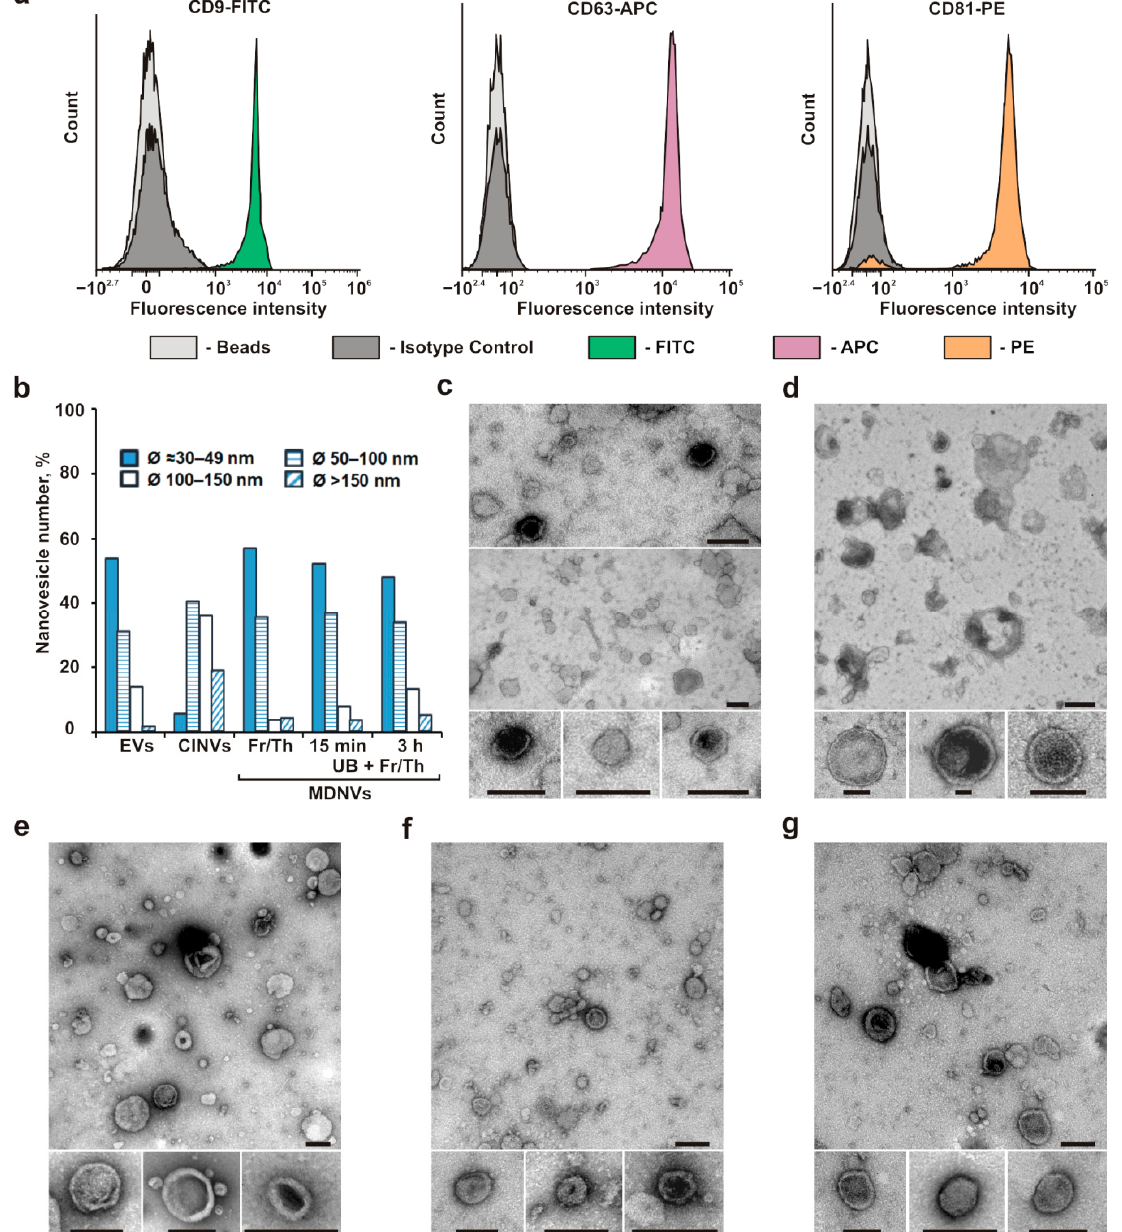
Figure 1. Characterization of EVs, CINVs, and MDNVs derived from human endometrial MSCs. ( a ) Natural EVs were stained with three endosome-specific tetraspanins; they exhibited the CD9 + , CD81 + , and CD63 + phenotype. ( b ) The amount of the EVs, CINVs, and MDNVs with di ff erent sizes (diameter, Ø) as evaluated by electron microscopy. ( c – g ) Transmission electron microscopy of ( c ) natural EVs and ( d ) CINVs isolated by 100 × g , 600 × g , and 15,000 × g di ff erential centrifugation, and MDNVs prepared by ( e ) Fr / Th, ( f ) 15 min UB + Fr / Th, or ( g ) 3 h UB + Fr / Th. Scale bar = 100